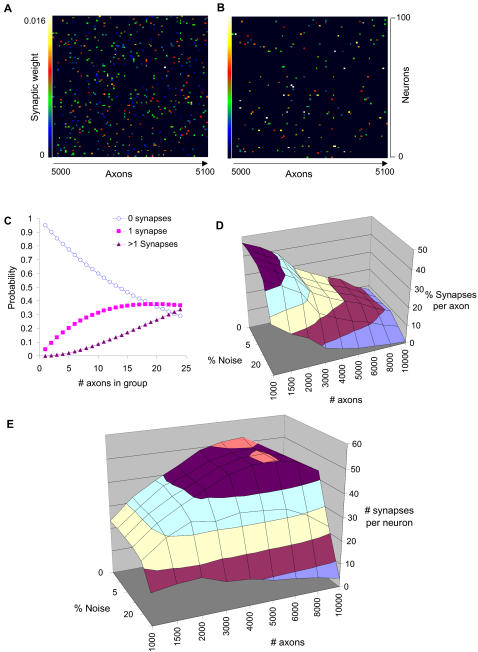
Method Scaling.(A) Actual synaptic weight matrix for axons 5000 to 5100. (B) Predicted synaptic weight matrix for same axons, using 20% noise and 80 repeats and regression fit as in (6D). Most of the low-weight synapses are missing. (C) Grouping axonal stimuli, with connection probability = 5%. More synapses were connected as the number of axons in the group increased, but the number of ambiguous cases with more than one synapses also rose. (D) Percent of synapses reported per axon in a 2-hour experiment at 300 ms per trial, with less than 1% false positives out of the reported synapses. Almost 50% of synapses were found for 1000 axons, as there was time for 240 repeats. With more axons, only a few trials were possible per axon and the percentage declined. Synapse identification fell sharply at 50% noise. (E) Number of synapses found per neuron in the same 2-hour experiment. More axons improved input coverage, but the number of possible trials decreased. There was a peak of ∼50 detected synapses per neuron, for ∼6000 axons.